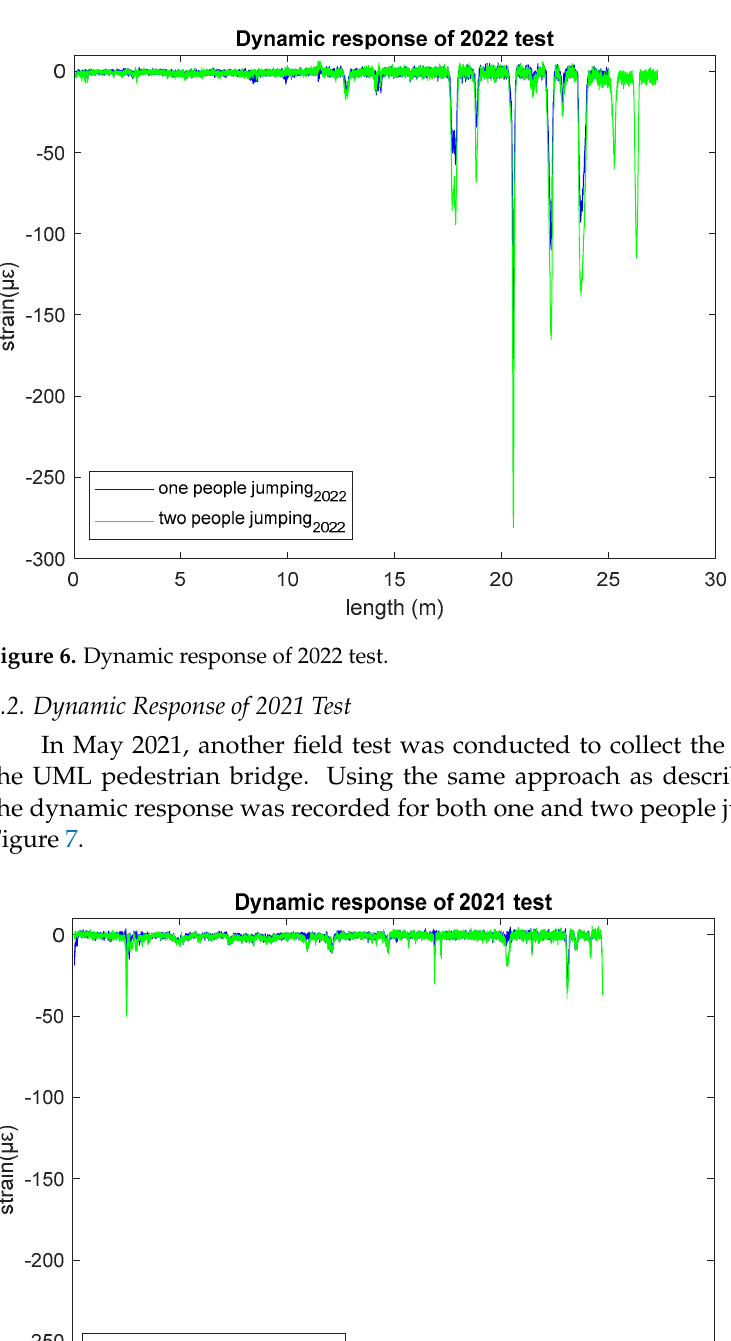
Figure 7. Dynamic response of 2021 test.